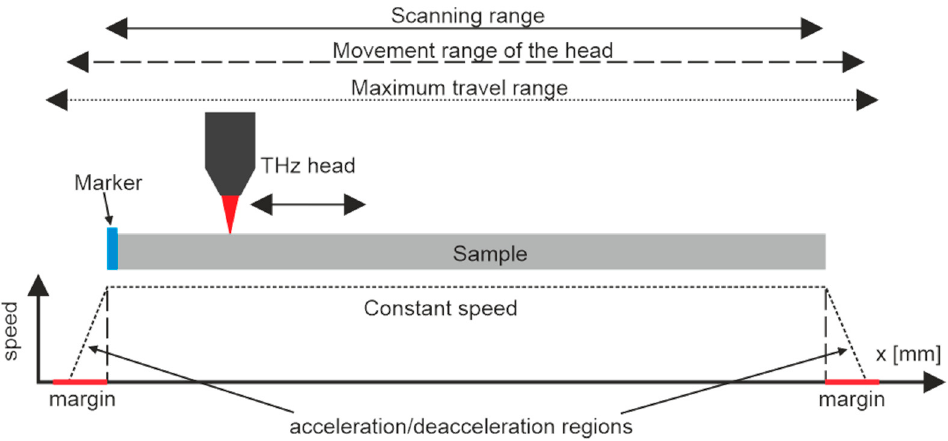
Figure 5. Concept of line-by-line scanning with the synchronization marker.